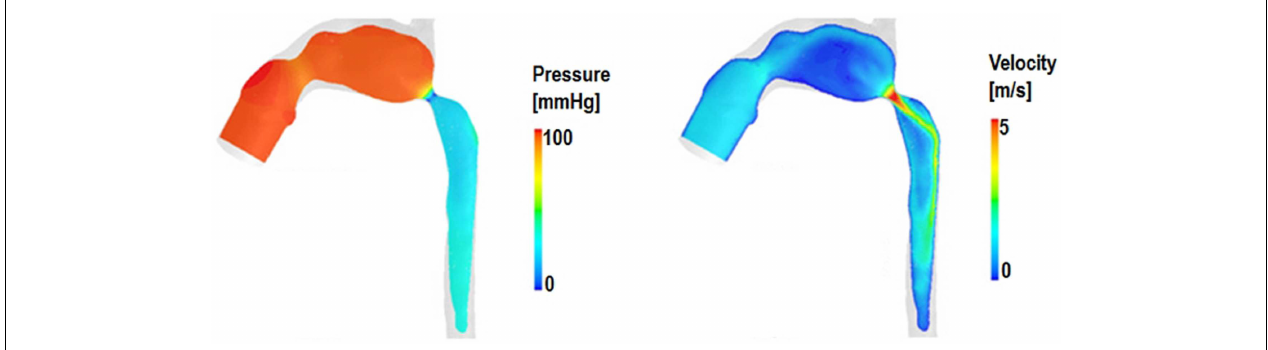
FIGURE 4 | Example of pressure and velocity maps in the 3D domain of a multi-scale simulation of HLHS post Stage 1 including a significant aortic coarctation, highlighting features such as pressure drop across the aortic narrowing as well as the velocity jet across the coarctation itself .